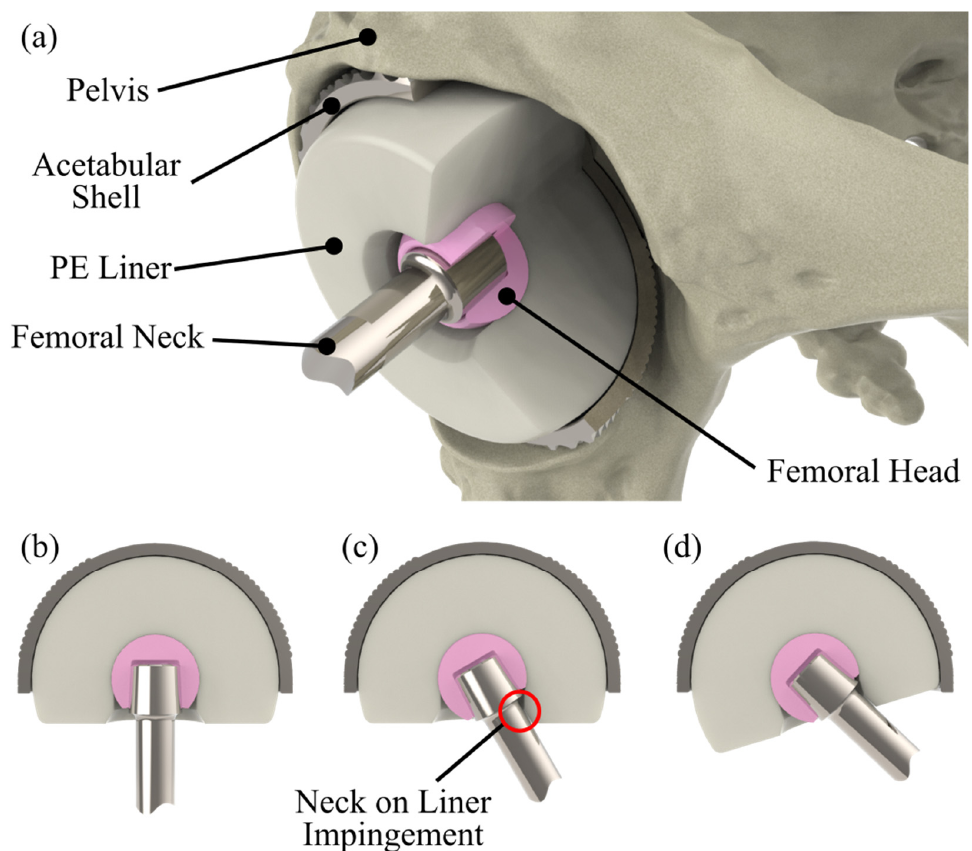
Figure 1. Cutaway images of a dual mobility implant illustrating ( a ) the implants construction, ( b ) its unarticulated position, ( c ) articulation at the inner bearing surface highlighting the location of neck-on-liner impingement which, with further movement, leads to ( d ) articulation at the outer bearing.